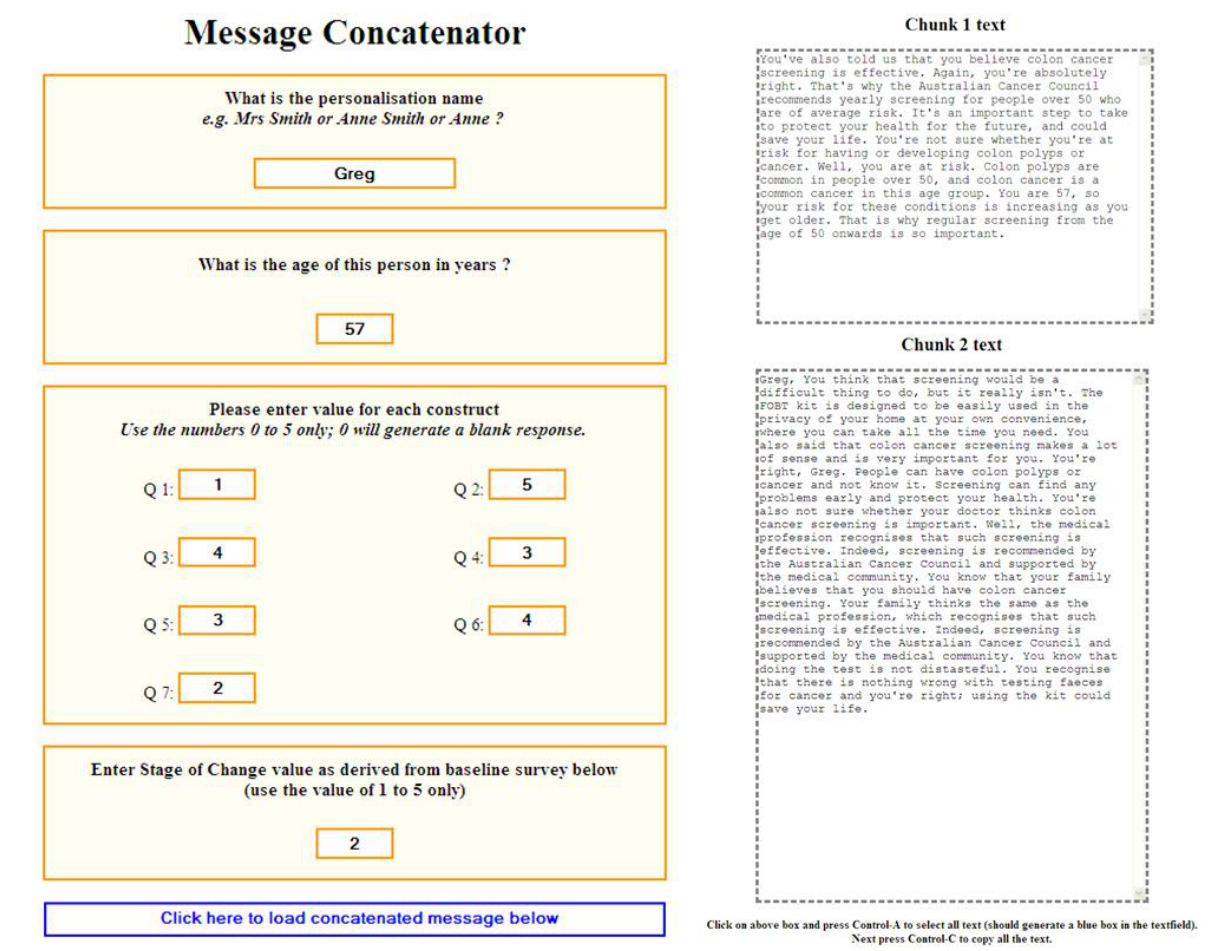
Figure 1. Message concatenator entry and resulting tailored message